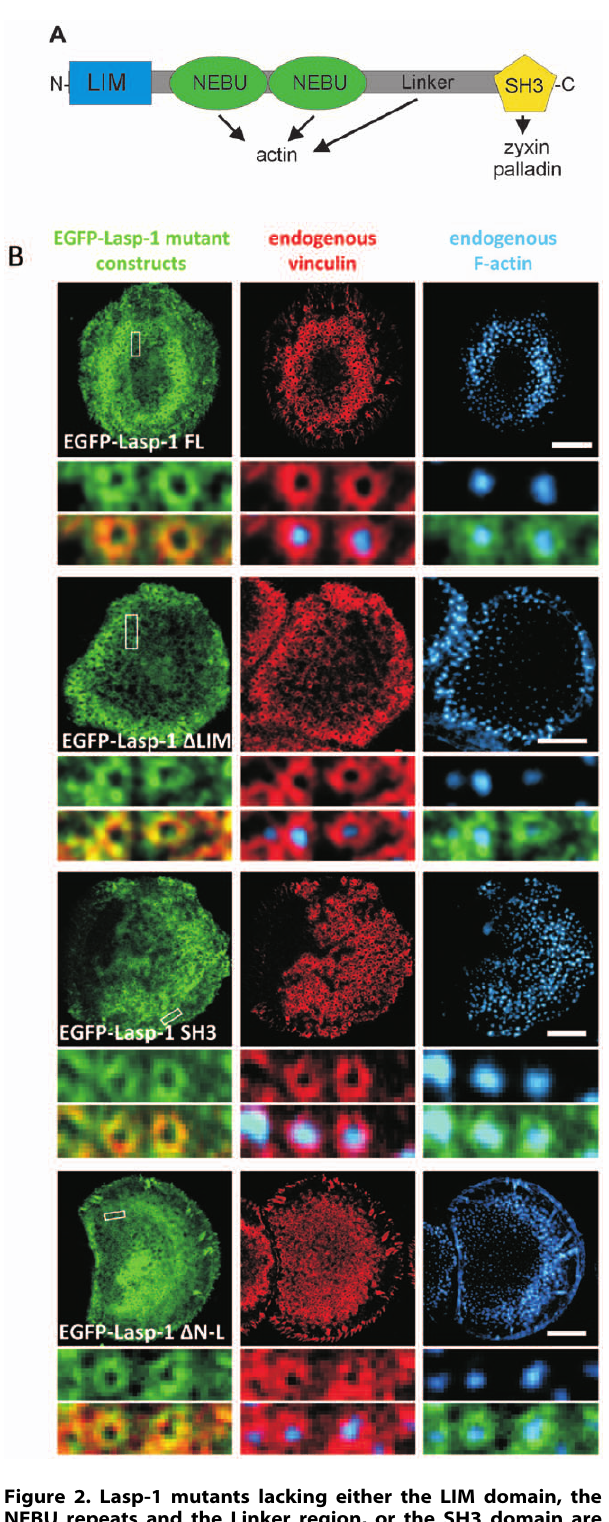
Figure 2. Lasp-1 mutants lacking either the LIM domain, the NEBU repeats and the Linker region, or the SH3 domain are still localized at podosomes. ( A ) Domain structure of Lasp-1 comprising an aminoterminal LIM domain, two nebulin (NEBU) repeats and an adjacent Linker region mediating actin binding, and a carboxyterminal SH3 (Src homology 3) domain that binds zyxin and palladin (N=aminoterminus, C=carboxyterminus). ( B ) Confocal micro- graphs of primary human macrophages transfected with EGFP-Lasp-1 deletion constructs (green) and stained with vinculin-specific